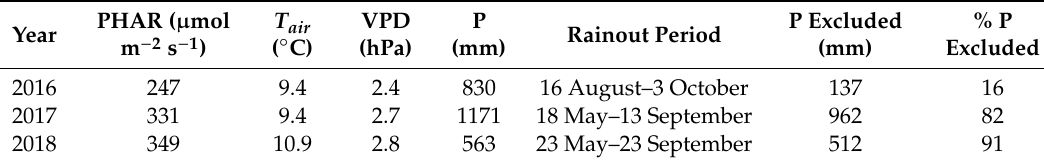
Table 3. Seasonal mean soil water content (vol %) at a 5–10 cm soil depth and soil temperature (°C) at a 10 cm soil depth in control and rain exclusion plots for the periods 16 August–3 October 2016, 18 May–13 September 2017, and 23 May–23 September 2018. Values are the mean ± SE of three sensors per treatment. Significant differences ( p < 0.1) between control and rain exclusion plots are marked in bold and italics.